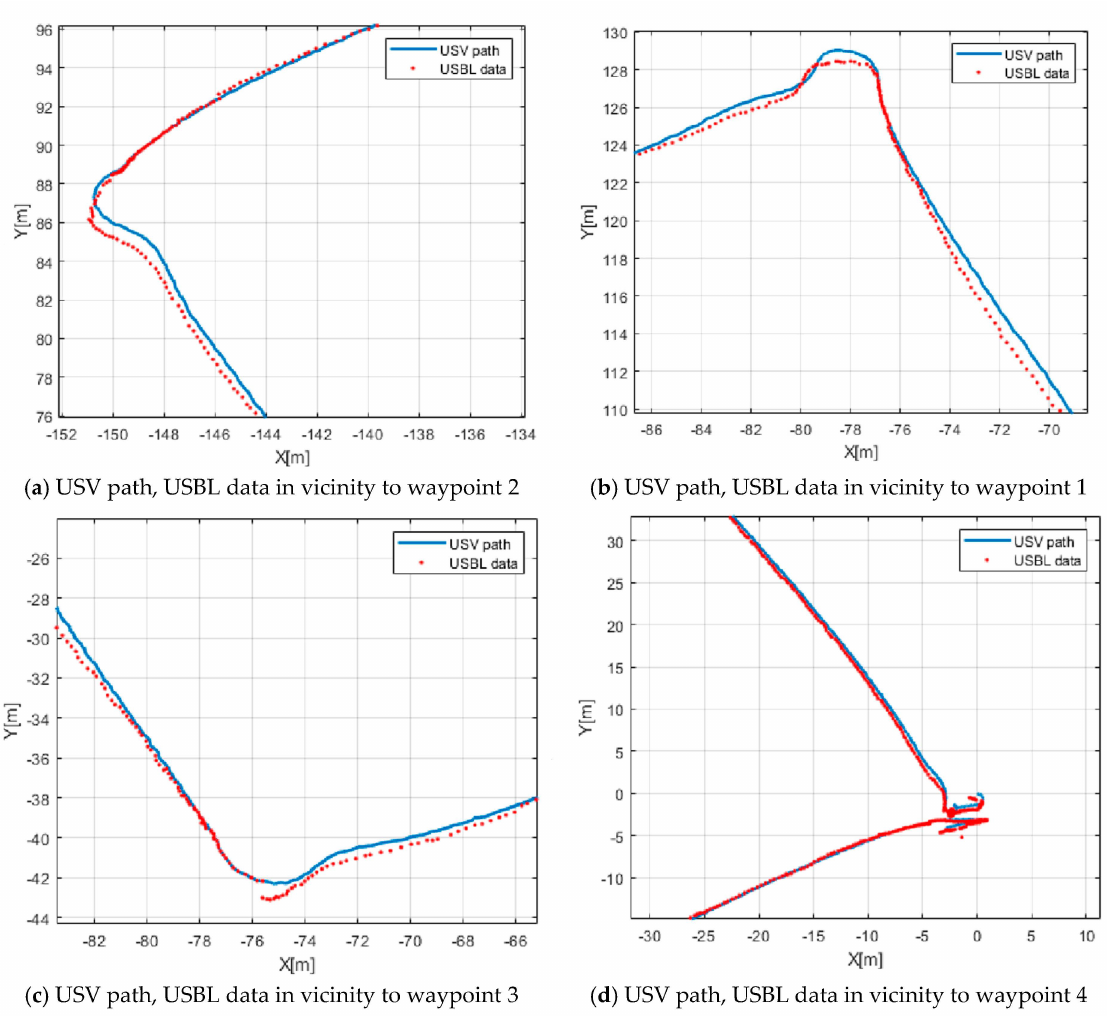
Figure 28. USV path and USBL